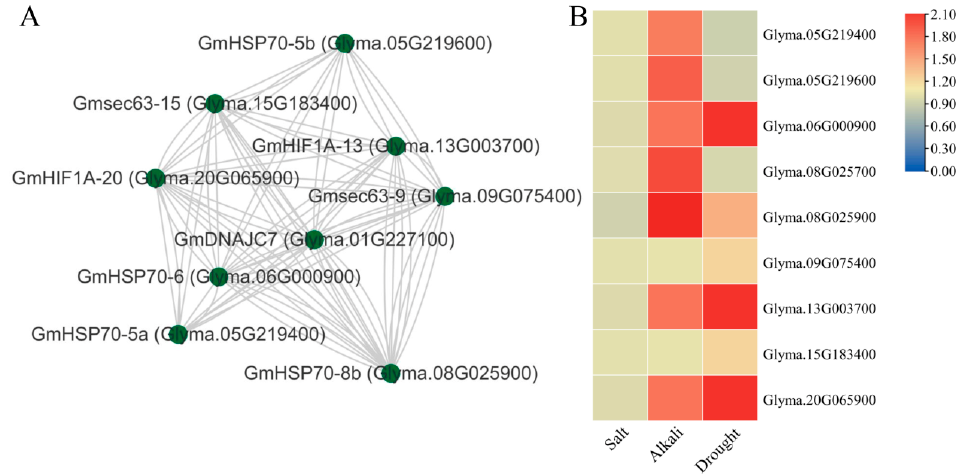
Figure 9. The prediction and relative expression of the GmDNAJC7-interacting proteins/genes. ( A ) The predicted protein–protein interaction network of GmDNAJC7 using the STRING database and Cytoscape software. Nodes represent the proteins and edges represent interactions. ( B ) Heatmap of the expression profiles for the predicted GmDNAJC7-interacting proteins encoding genes in response to alkali, salt, and drought stresses. The heatmap was constructed using the TBtools. Gene expression profiles in soybean under alkaline salt, saline and drought stresses were obtained by using previously published Affymetrix GeneChip datasets: GSE17883, GSE41125, GSE50408. The color key represents the fold change (stress vs. control) scaled by row, with red to blue indicating upregulation to